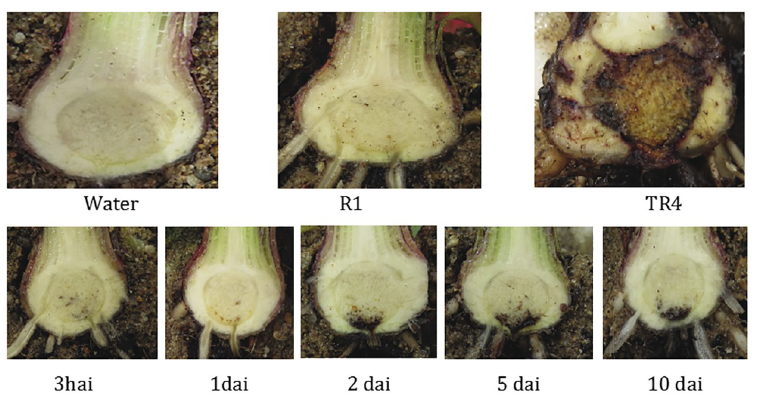
Fig 2. Durability of induced resistance in Cavendish banana cv. Grand Naine after pre-inoculating with R1. Cross sections of corms were conducted at six weeks after TR4 inoculation. Top row shows: water, R1 and F . odoratissimum TR4 inoculation controls. Bottom row shows: corms of R1 pre-inoculated plants that were challenged with TR4 after 3 hours, 1, 2, 5 and 10 days.